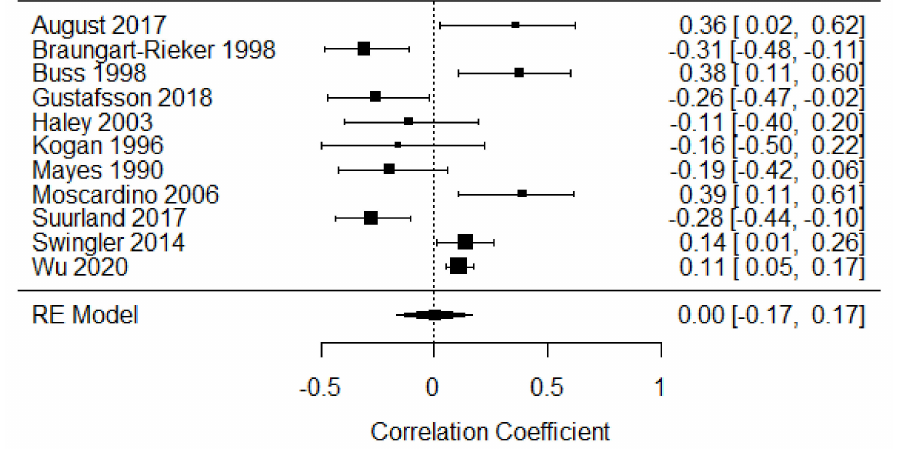
Figure 6. Forest plot of year 1 parent-focused strategies. Note: RE = Random-Effects